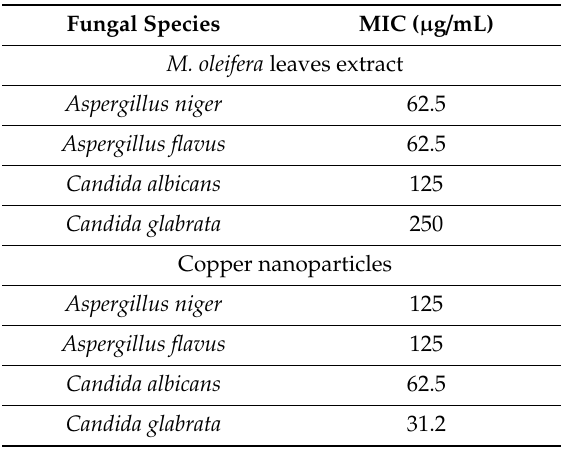
Table 7. Anti-fungal activity (MIC